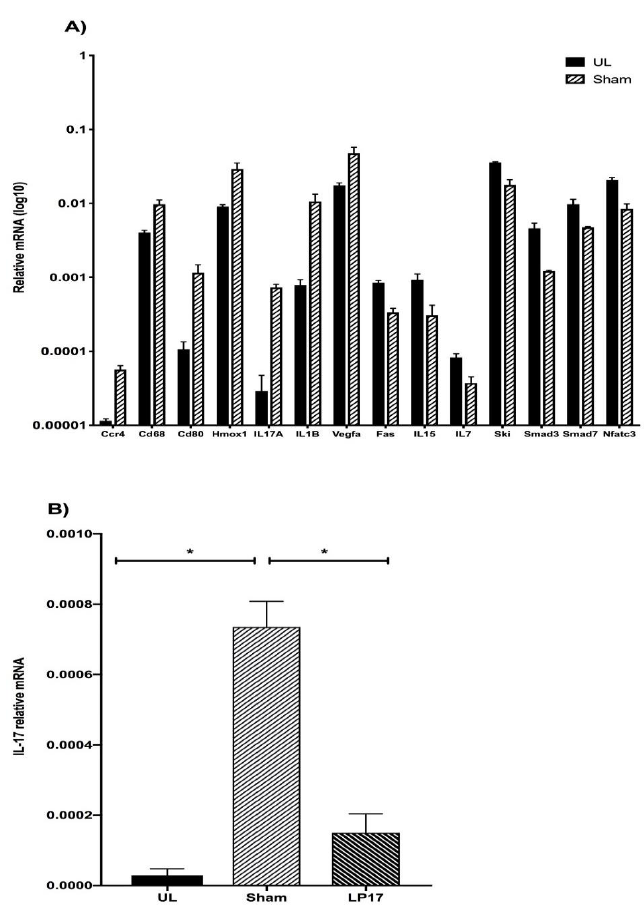
Figure 4. Modulation of immunoregulatory genes by TREM-1. Dissected gingiva from unligated control sites (UL) and ligated shame treated sites (Sham) for 5 days. The mRNA expression of 92